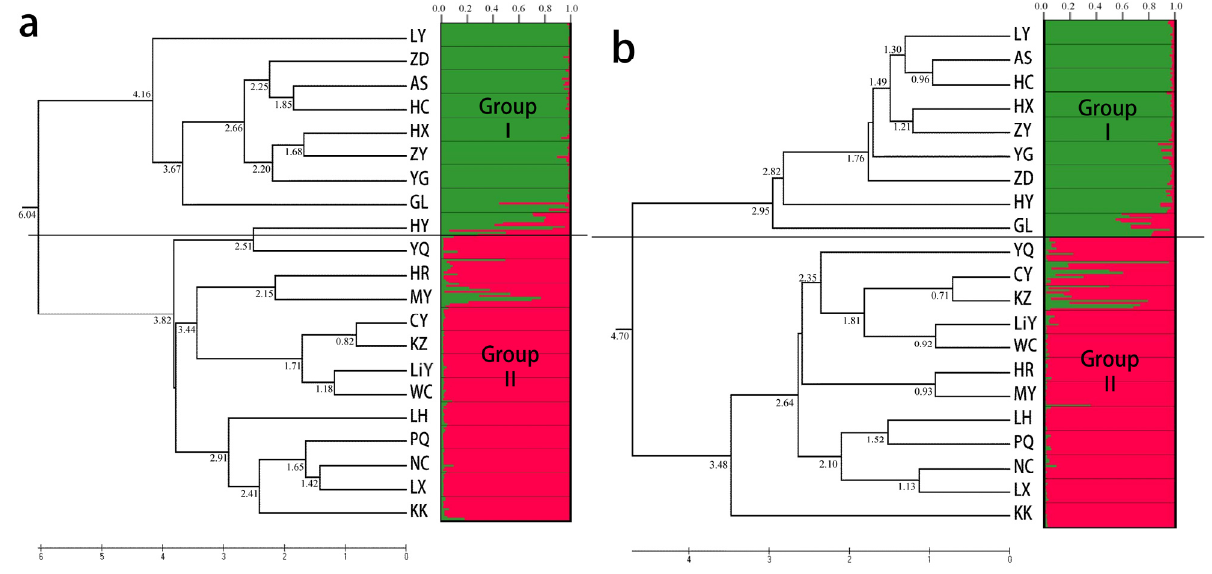
Figure 1. UPGMA dendrogram for the wild Siberia apricot populations based on Nei’s genetic distance [40], as revealed using ( a ) ISSR markers; ( b ) SRAP markers; and ( c ) SSR markers. The distance coefficients between populations obtained by Cluster analyses are marked on branches and the x